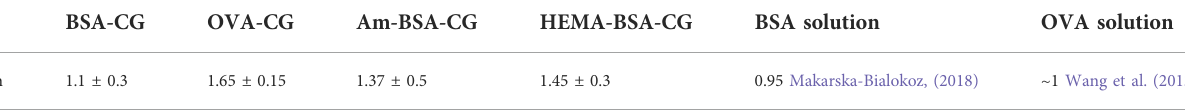
TABLE 5 Number of binding sites on albumin-based cryogels and biomolecule solutions.